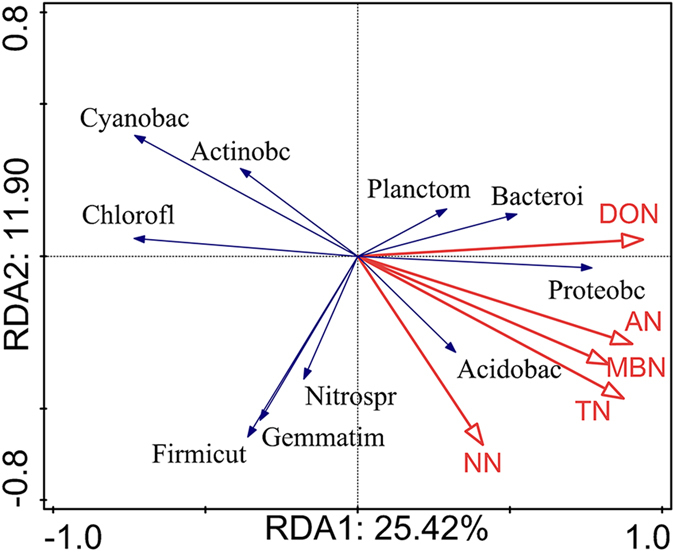
RDA analysis between soil N fractions and soil bacterial phyla following afforestation.The abbreviation were as follow: Proteobacteria (Proteobac), Actinobacteria (Actinoba), Acidobacteria (Acidobac), Chloroflexi (Chlorofl), Planctomycetes (Planctom), Gemmatimonadetes (Gemmatim), Bacteroidetes (Bacteroi), Cyanobacteria (Cyanobac), Nitrospirae (Nitrospi), Firmicutes (Firmicut), Armatimonadetes (Armatimo), Verrucomicrobia (Verrucom).